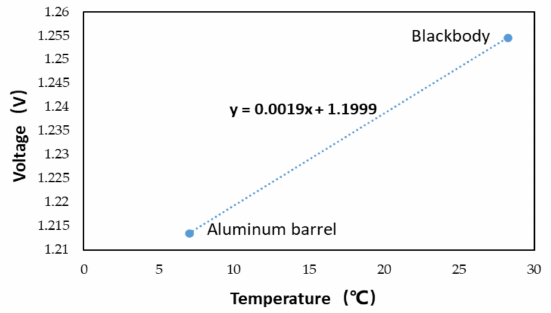
Figure 25. Overall calibration